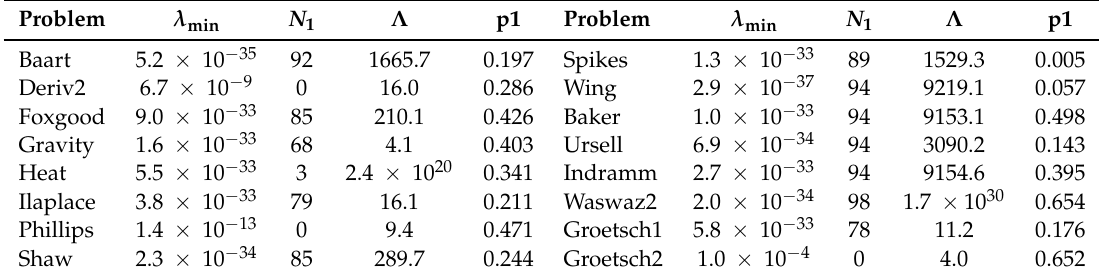
Table 1. Characteristics of matrix A T A and the solution u ∗